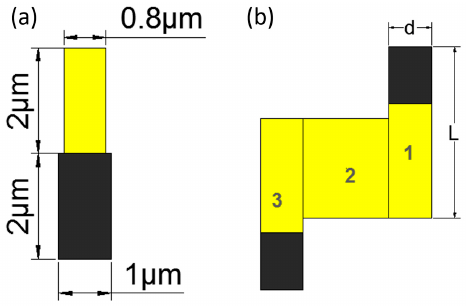
Figure 13. ( a ) The shape of the nanorobot; and ( b ) the division of the Z-shaped nanorobot.